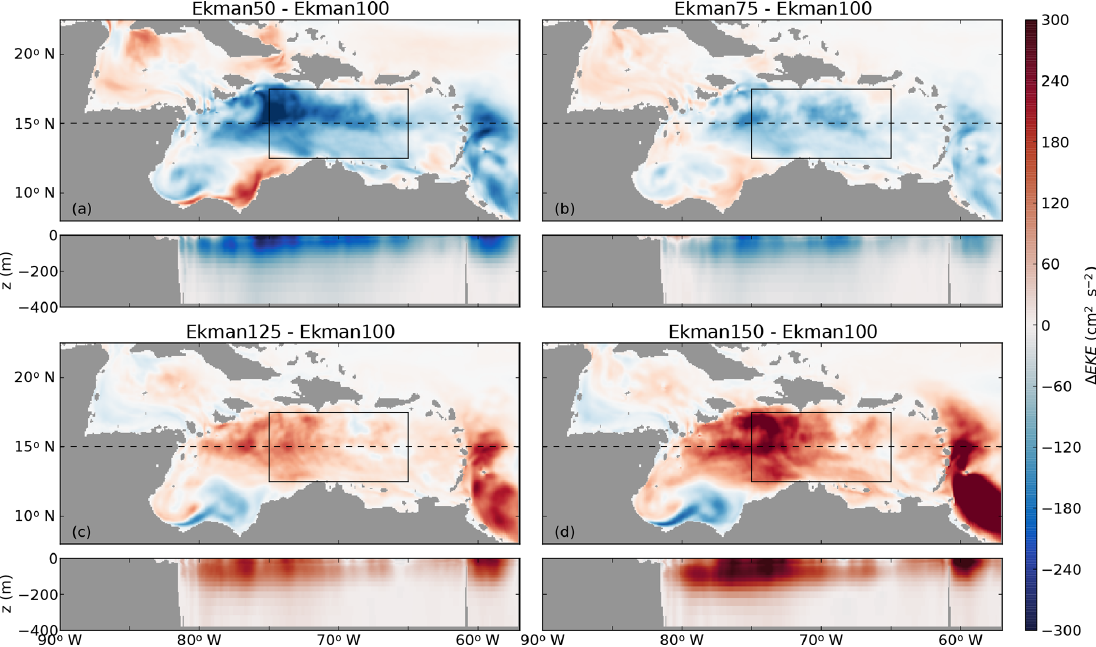
Figure 11. EKE anomaly compared to Ekman100 (Fig. 4) at the near surface and at a cross section at 15 ◦ N in (a) Ekman50, (b) Ekman75, (c) Ekman125, and (d) Ekman150. Positive values correspond to enhanced EKE compared to Ekman100. The black box indicates the interior of the Caribbean Sea (12.5–17.5 ◦ N, 65–75 ◦ W). The dashed line shows the location of the cross sections in the lower panels.